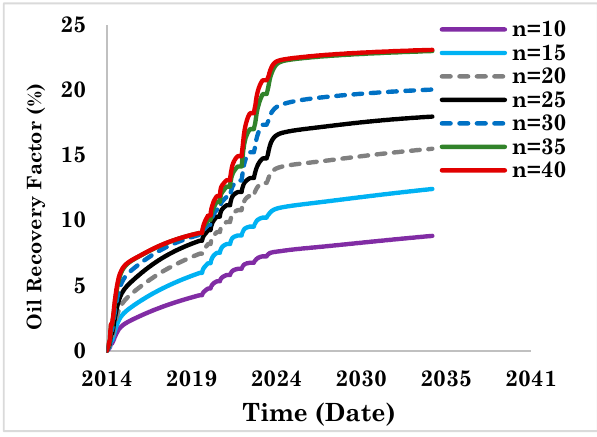
Figure 17. C 2 H 6 Injection (Extended Cycle Size) 31 API Oil